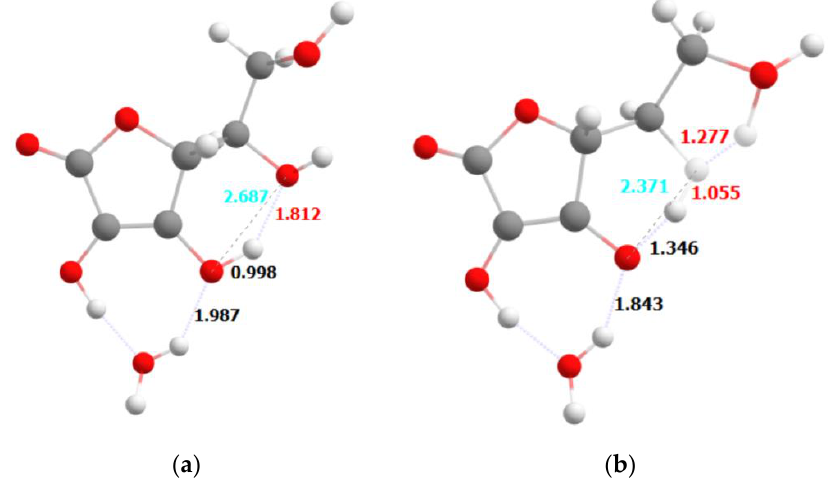
Figure 6. The geometries of the ascorbic acid in its ground state ( a ) and the conical intersection ( b ).